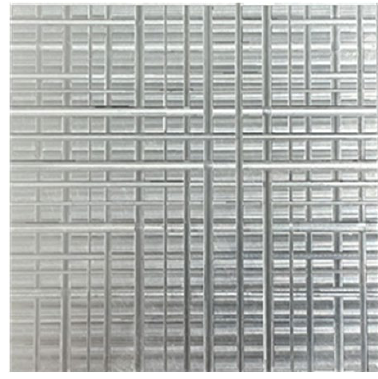
Figure 6. Flat physical map.